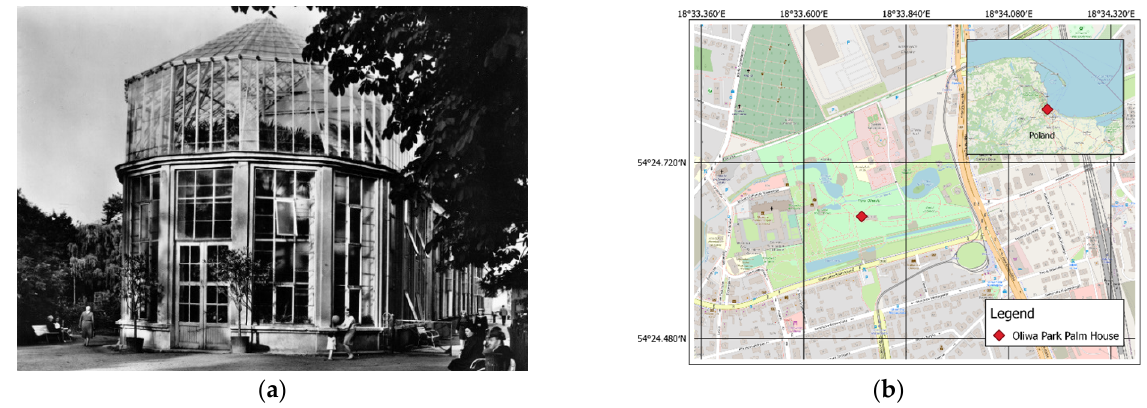
Figure 1. ( a ) Oliwa Park Palm House, 1972–1978 (photo credit: Andrzej Zborski). ( b ) Site location (WGS-84).